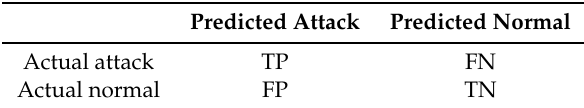
Table 1. The confusion